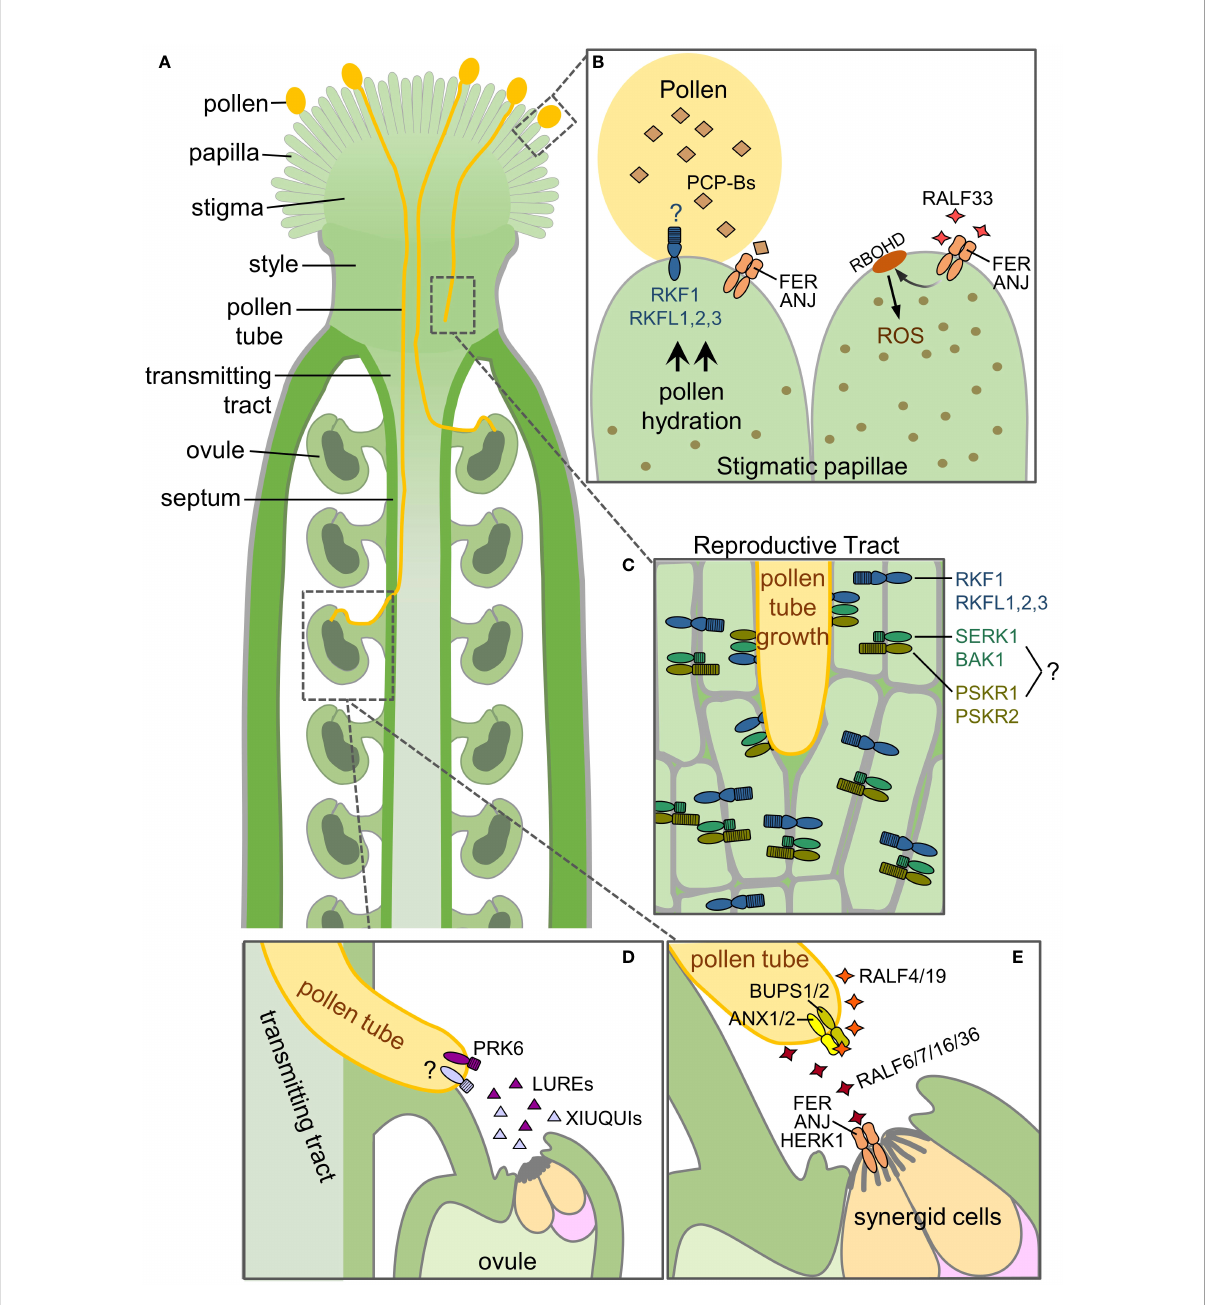
FIGURE 1 Receptor kinases and their respective ligands for compatible pollen-pistil interactions. This diagram illustrates the RLKs, RKs and their ligands functioning at different stages of the pollen-pistil interactions in Arabidopsis . (A) Overview of the different structures in a pollinated pistil. (B) Pollen reception at the stigmatic papilla. (C) Growth of the pollen tube through the reproductive tract (stigma, style, transmitting tissue). (D) Ovular guidance of the pollen tube to an unfertilized ovule. (E) Pollen tube reception at the ovule. See text for further